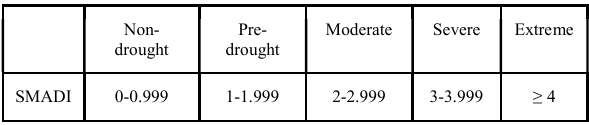
Table 1. Drought categories after SMADI The global datasets included in SMADI are the daily MODIS/Terra LST (MOD11C1 v.6), the daily reflectance (MOD09CMG v.6, from which NDVI was computed), and the daily SMOS L3 soil moisture (BEC v2.0, Barcelona Expert Center, 2019). All of them are integrated in SMADI at a spatial resolution of 0.05° and a biweekly temporal rate. SMADI was calculated only for grassland and cropland areas, as indicated by the MODIS/Terra Land Cover Types map (MOD12C1). A more detailed description of the SMADI basis and its calculation can be found in Sánchez et al. (2018).